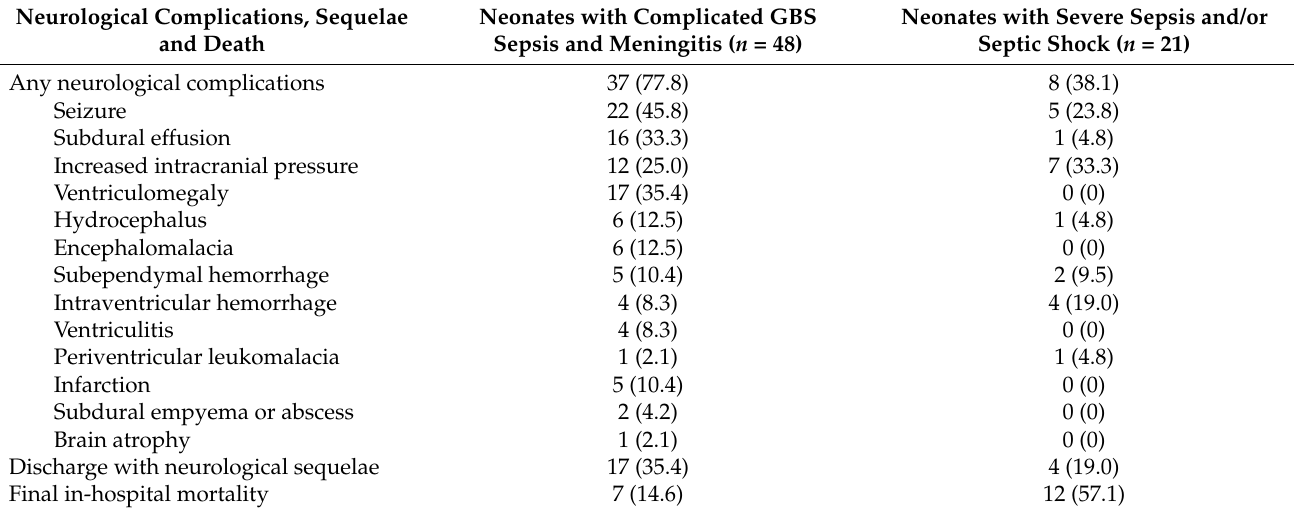
Table 2. Neurological complications in neonates with complicated group B streptococcal (GBS) sepsis in CGMH, 2003–2020.